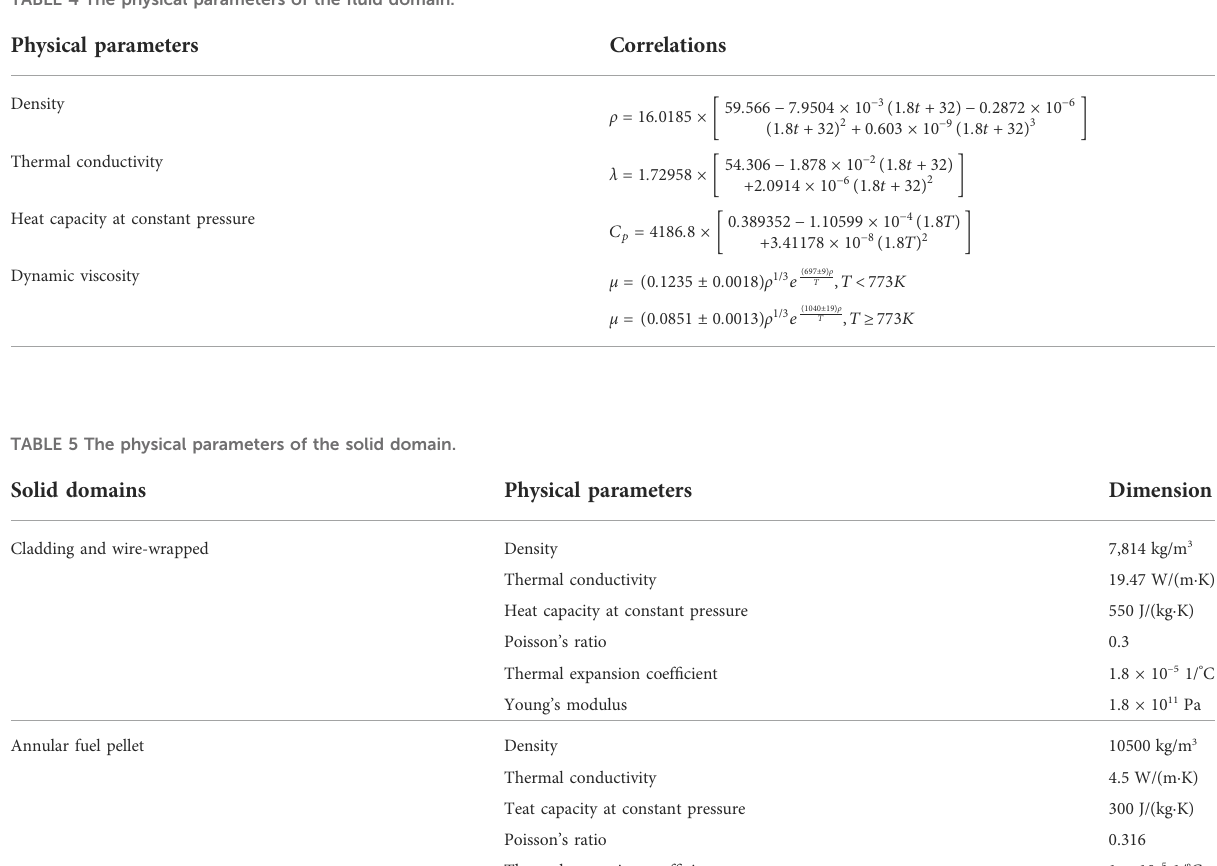
TABLE 4 The physical parameters of the fl uid domain.